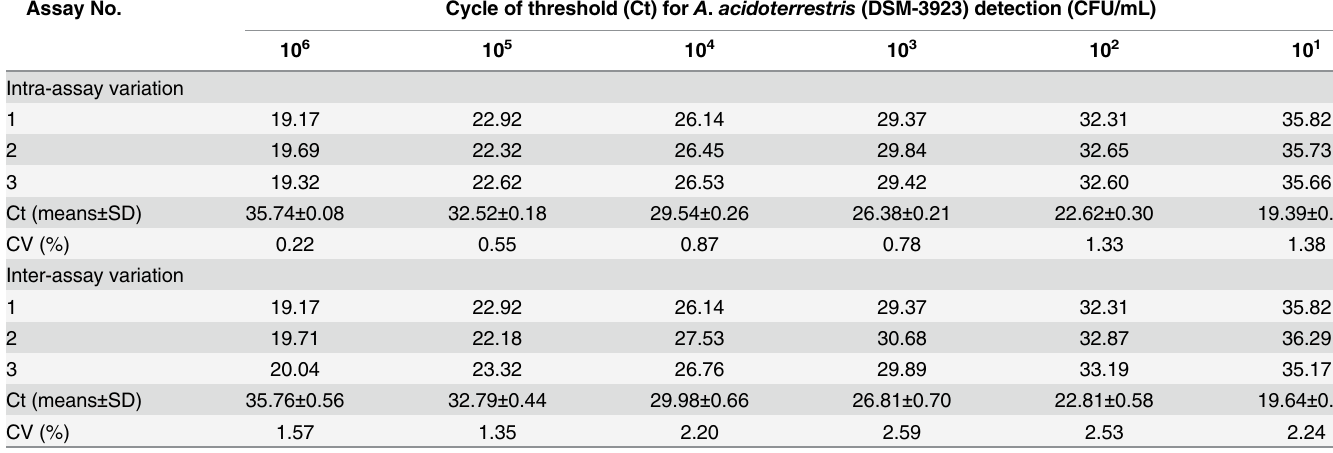
Table 2. Repeatability of Ct values in intra- and inter-assays using the IMS- real-time PCR. Assay No.